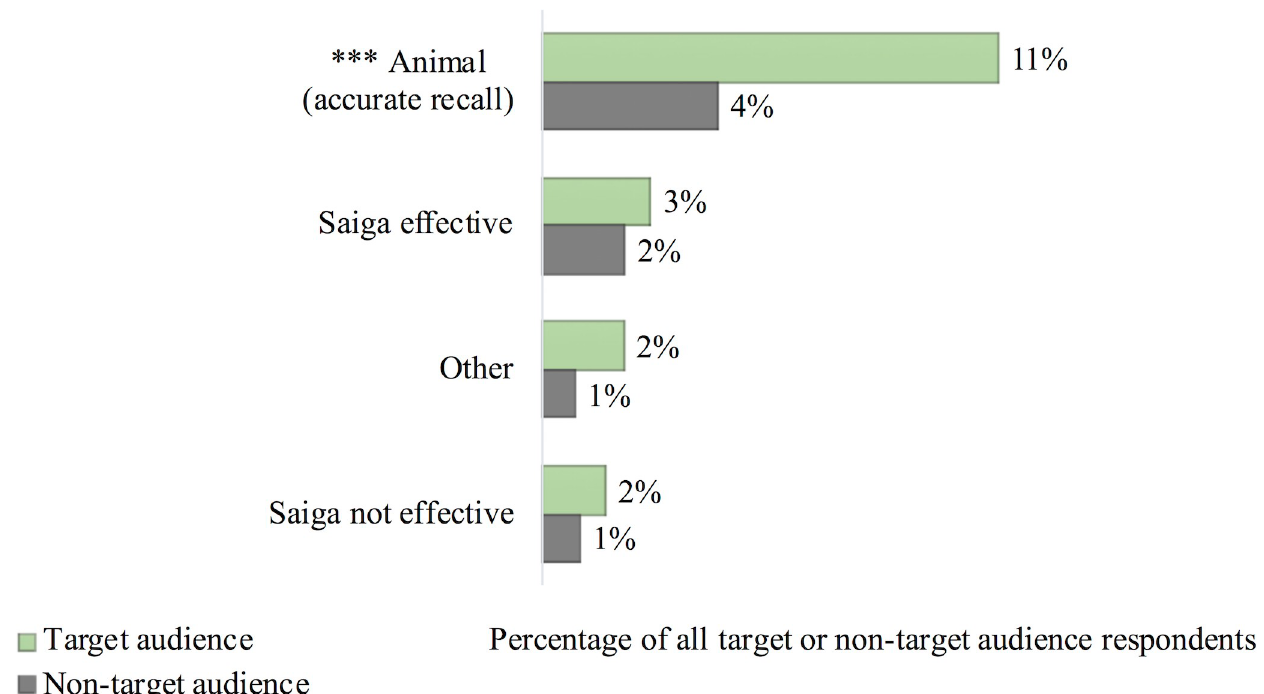
Fig 3. Content of the ‘media attention’ respondents described. ‘Animal’ content refers to generally accurate descriptions of the intervention message. Percentages are out of the total number of target or non-target audience respondents (438 and 1,678 people respectively). ��� denotes a p-value < 0.001 significant association between the target audience and accurate intervention